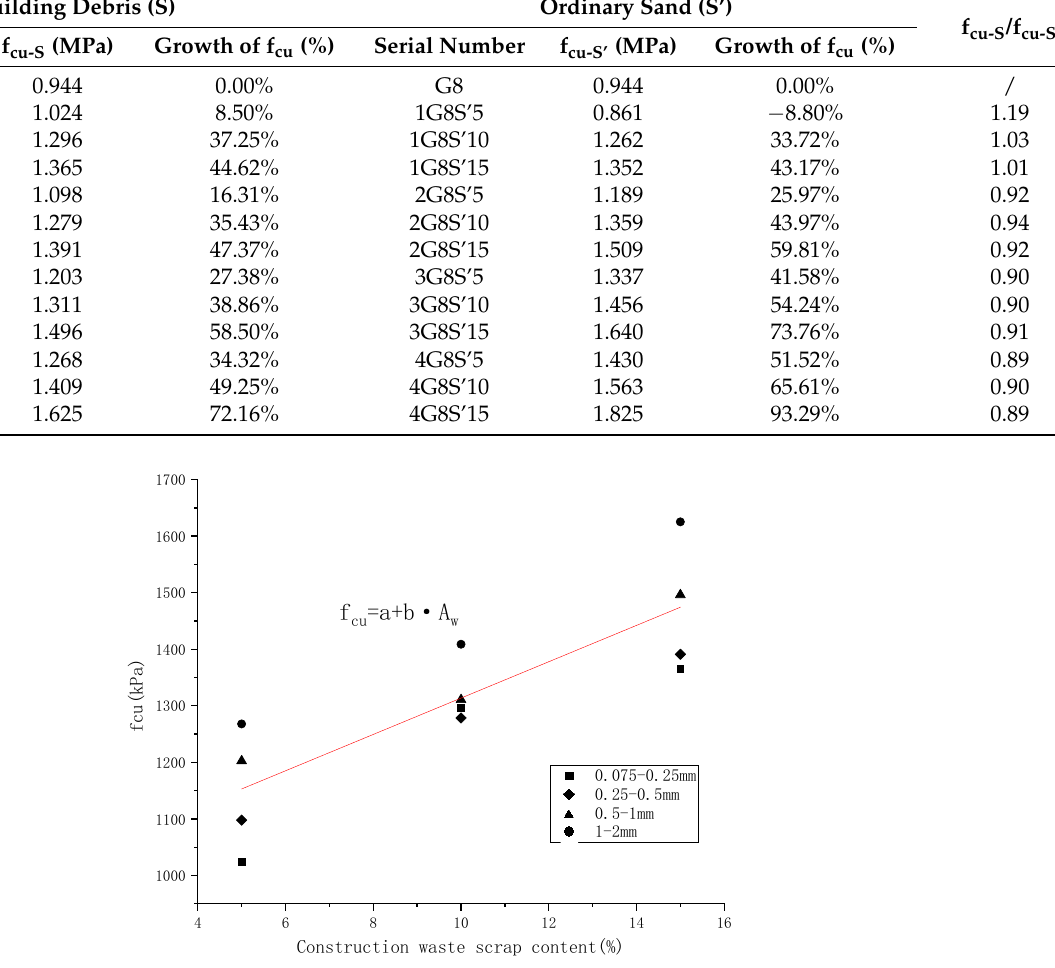
Figure 2. Relationship between solidified building debris silt’s unconfined compressive strength with content.